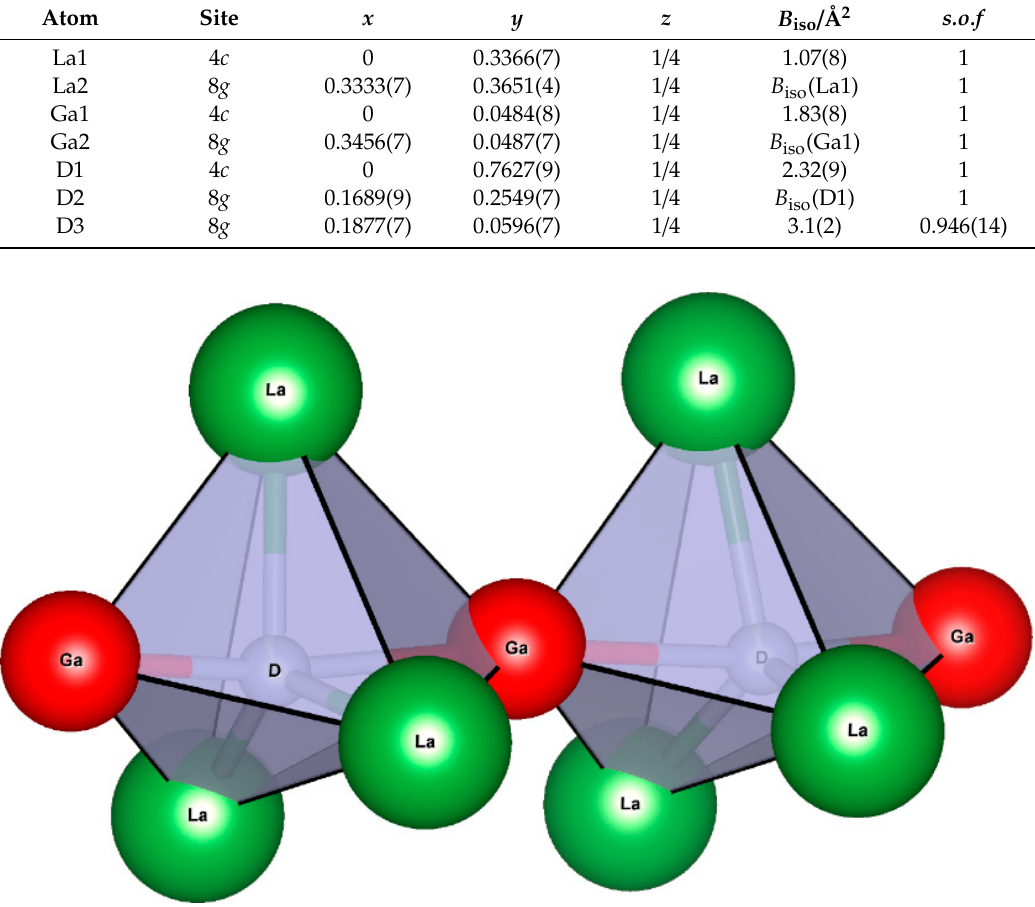
Figure 4. Two DLa 3 Ga 2 coordination polyhedra in LaGaD 1.63(1) connected via a common corner. Table 1. Crystal structure of LaGaD 1.63(1) derived from neutron diffraction data, Cmcm , a = 12.7414(6) Å, b = 12.6178(6) Å, c = 4.2589(2) Å.